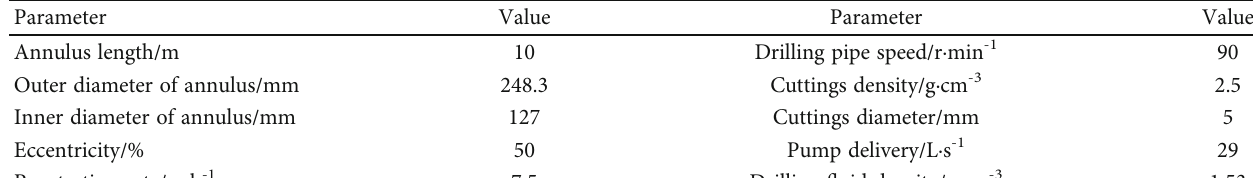
Table 1: Basic parameters of the simulation.